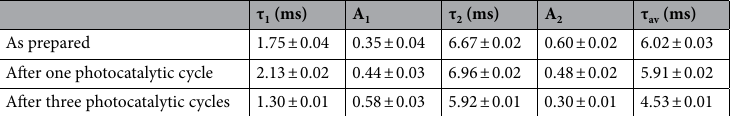
Table 3. Decay lifetimes τ i (i = 1, 2), amplitudes A i (i = 1, 2), average lifetimes τ av obtained for the TiO 2 /β- NaYF 4 : 10% Eu 3+